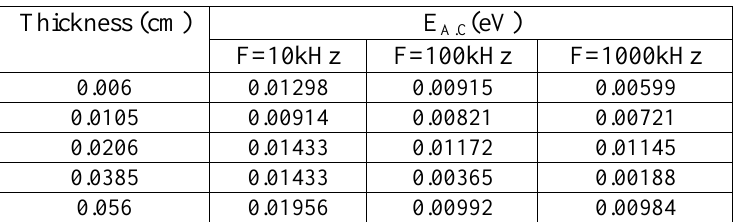
values of PMMA A.C